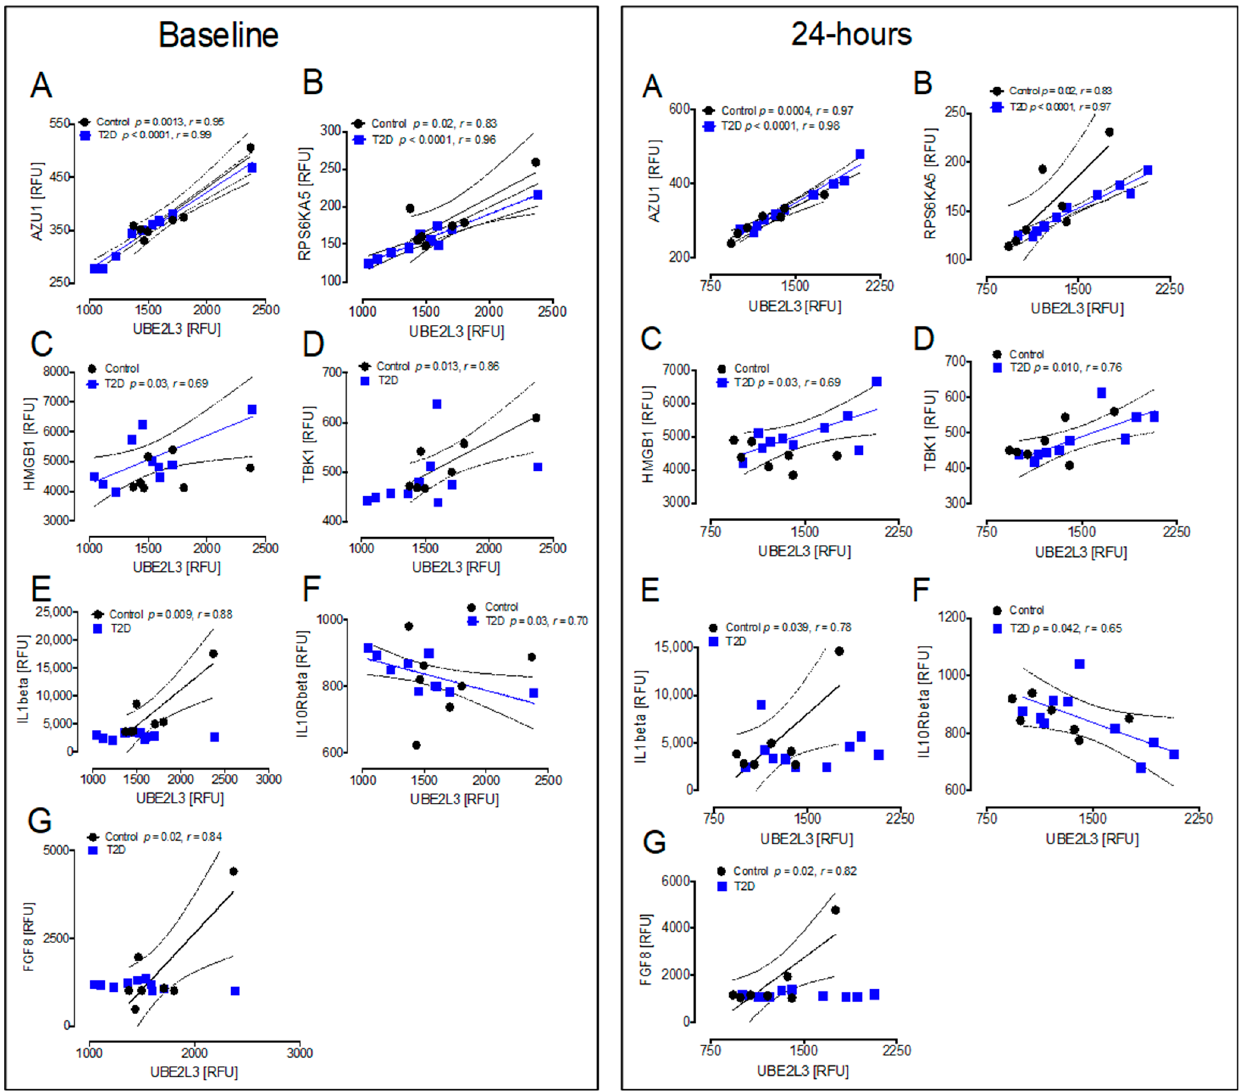
Figure 7. Comparison of the correlation of UBE2L3 with inflammatory markers at baseline and at 24 h. In T2D at 24 h, UBE2L3 correlated positively with AZU1 ( A ), RPS6KA5 ( B ), HMGB1 ( C ), and TBK1 ( D ), and negatively with IL10Rbeta ( F ). In controls at 24 h, UBE2L3 correlated positively with AZU1 ( A ), RPS6KA5 ( B ), IL1beta ( E ), and FGF8 ( G ). In comparison with the correlation of those markers at baseline, the same correlations were seen for both T2D and controls for AZU1 ( A ), RPS6KA5 ( B ), HMGB1 ( C ), IL1beta ( E ), IL10Rbeta ( F ), and FGF8 ( G ), and only differed for TBK1, which correlated in T2D at 24 h ( D ), but not at baseline, and did not correlate with controls at 24 h ( D ), despite correlating at baseline. UBE2L3, ubiquitin-conjugating enzyme E2L 3; AZU1, azurocidin 1; RPS6KA5, ribosomal protein S6 kinase 5; IL1beta, interleukin 1 beta: FGF8, fibroblast growth factor 8; HMGB1, high mobility group box 1; IL10Rbeta, interleukin 10 receptor beta; TBK1, TANK-binding kinase 1; RFU, relative fluorescent units.